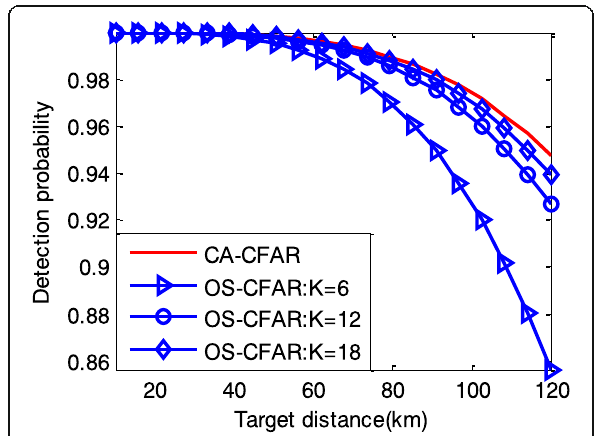
Fig. 7 Probability of detection for different distances without an interfering target